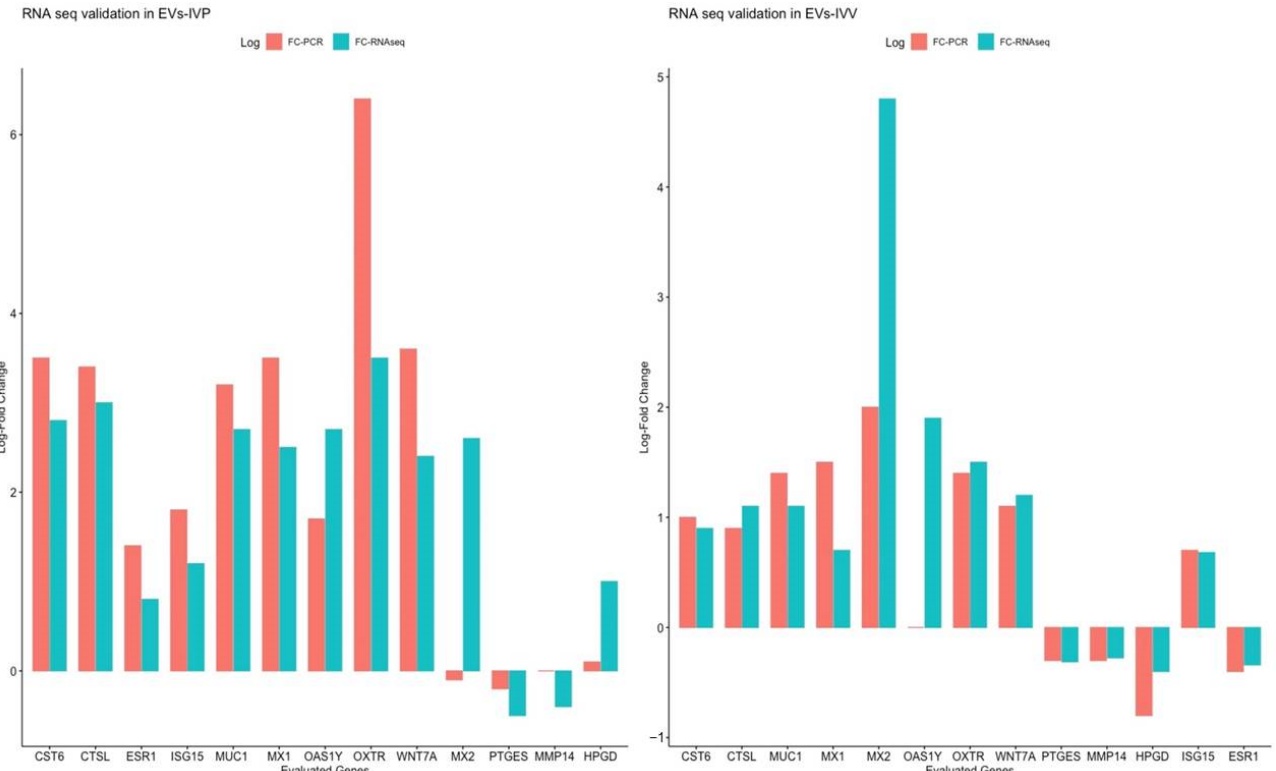
Figure 7. Fold change graphic comparing the fold change in RNA seq and RT qPCR of each evalu- ated gene. Data on Y-axis represent the log of fold change obtained from PCR analysis (red) and RNAseq (green). A Pearson correlation analysis showed a similar fold change tendency for most of the genes except MX2 in the EVs-IVP group.